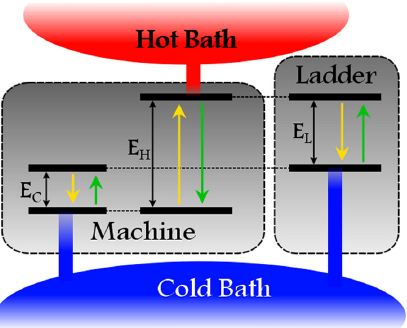
FIG. 2. Energy-level structure of the minimal thermal clock- work. The transitions induced by H are indicated by arrows. int The green arrows indicate the transition where the ladder gets exited. The yellow arrows show the reverse transition. Coupling the qubit with the biggest energy gap to the hot bath introduces a bias toward the transition that is indicated by the green